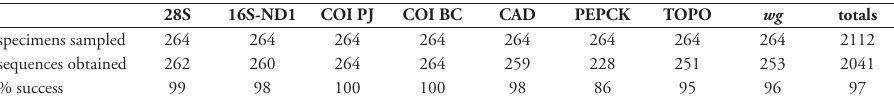
Table 3. Numbers and percentages of sequences used in analyses by